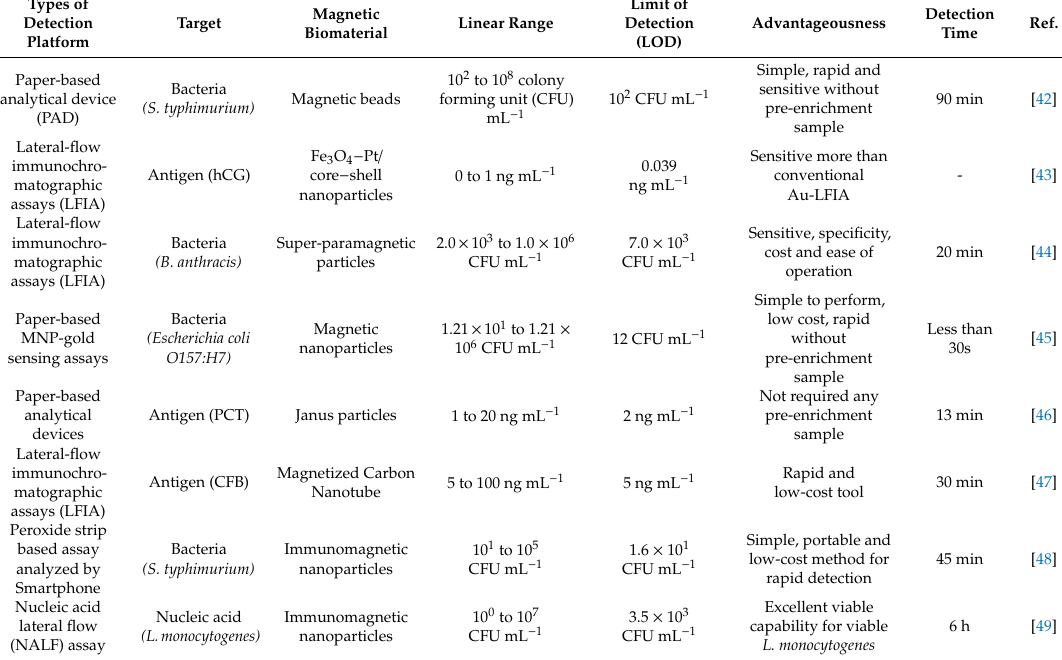
Table 2. Summary of the strategies used for magnetic-biomaterials-based colorimetric